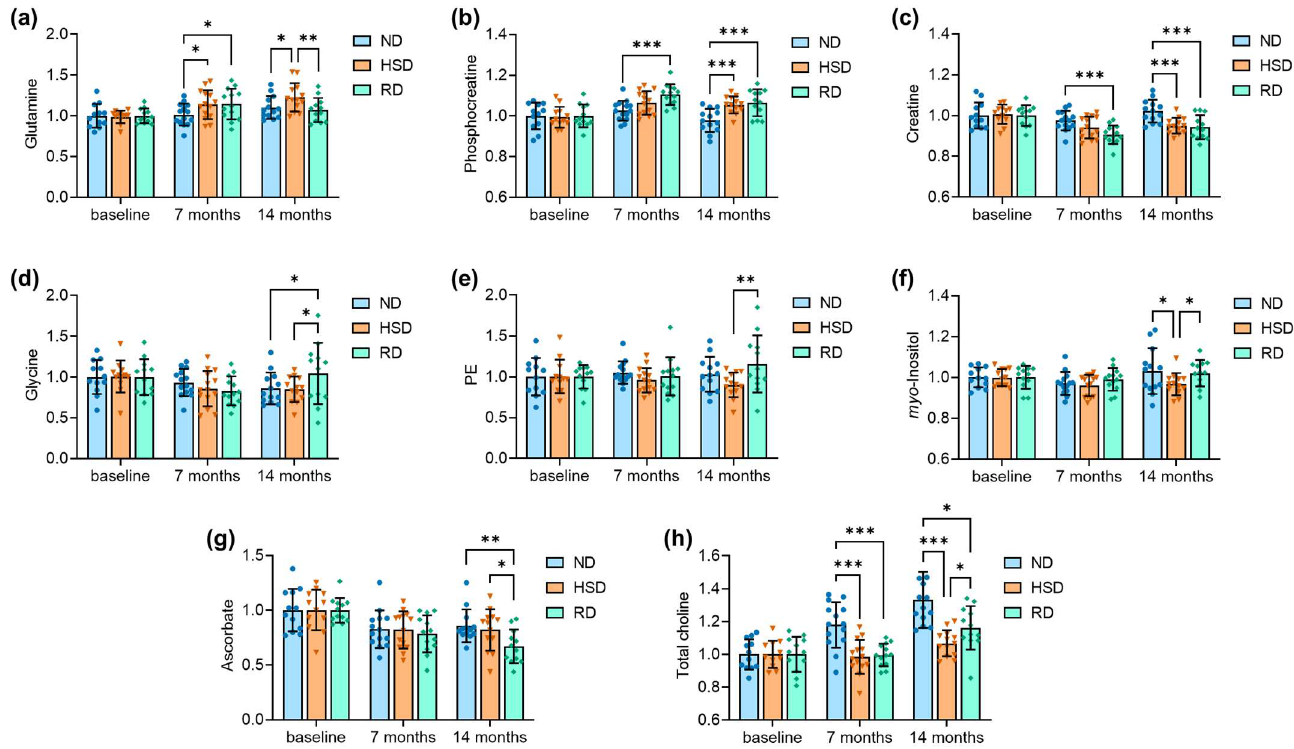
Figure 4. Hippocampal VIP metabolite concentrations for glutamine ( a ), phosphocreatine ( b ), crea- tine ( c ), glycine ( d ), PE ( e ), myo -inositol ( f ), ascorbate ( g ) and total choline ( h ) representing major age- and/or diet-induced alterations to the metabolite profiles. Data are normalized to the mean baseline concentration within each experimental group. Bars are means ± SDs. Symbols overlaid on bars represent independent measurements from each mouse for normal (ND), high-salt (HSD), and reversed (Rev) diet groups. * p < 0.05, ** p < 0.01, *** p < 0.001 compared to ND or as indicated using Fisher LSD tests after significant effects of diet were determined by two-way